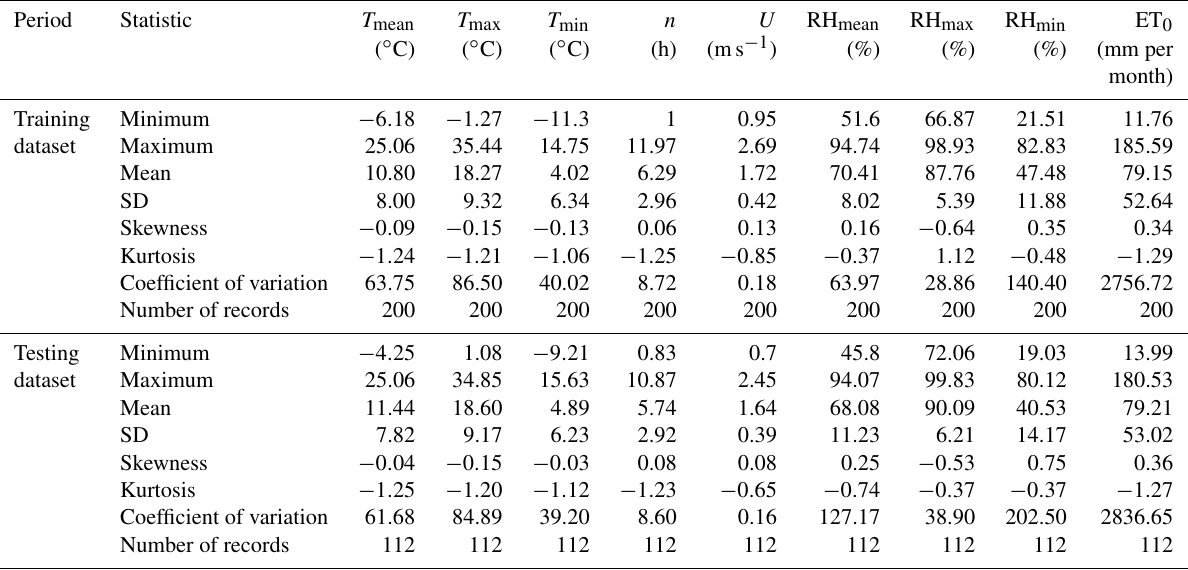
Table 1. Basic statistics of the data used in the study during the training and testing periods. Period